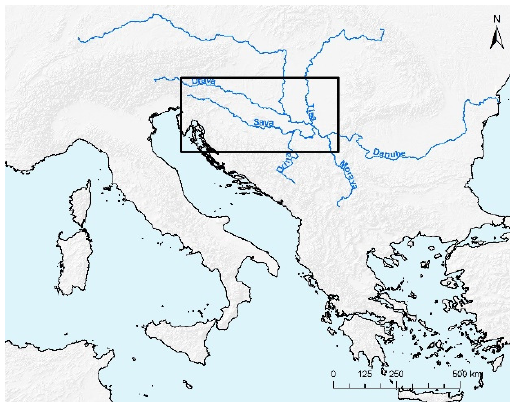
Figure 1. Position of the study area (rectangle) within SE Europe.